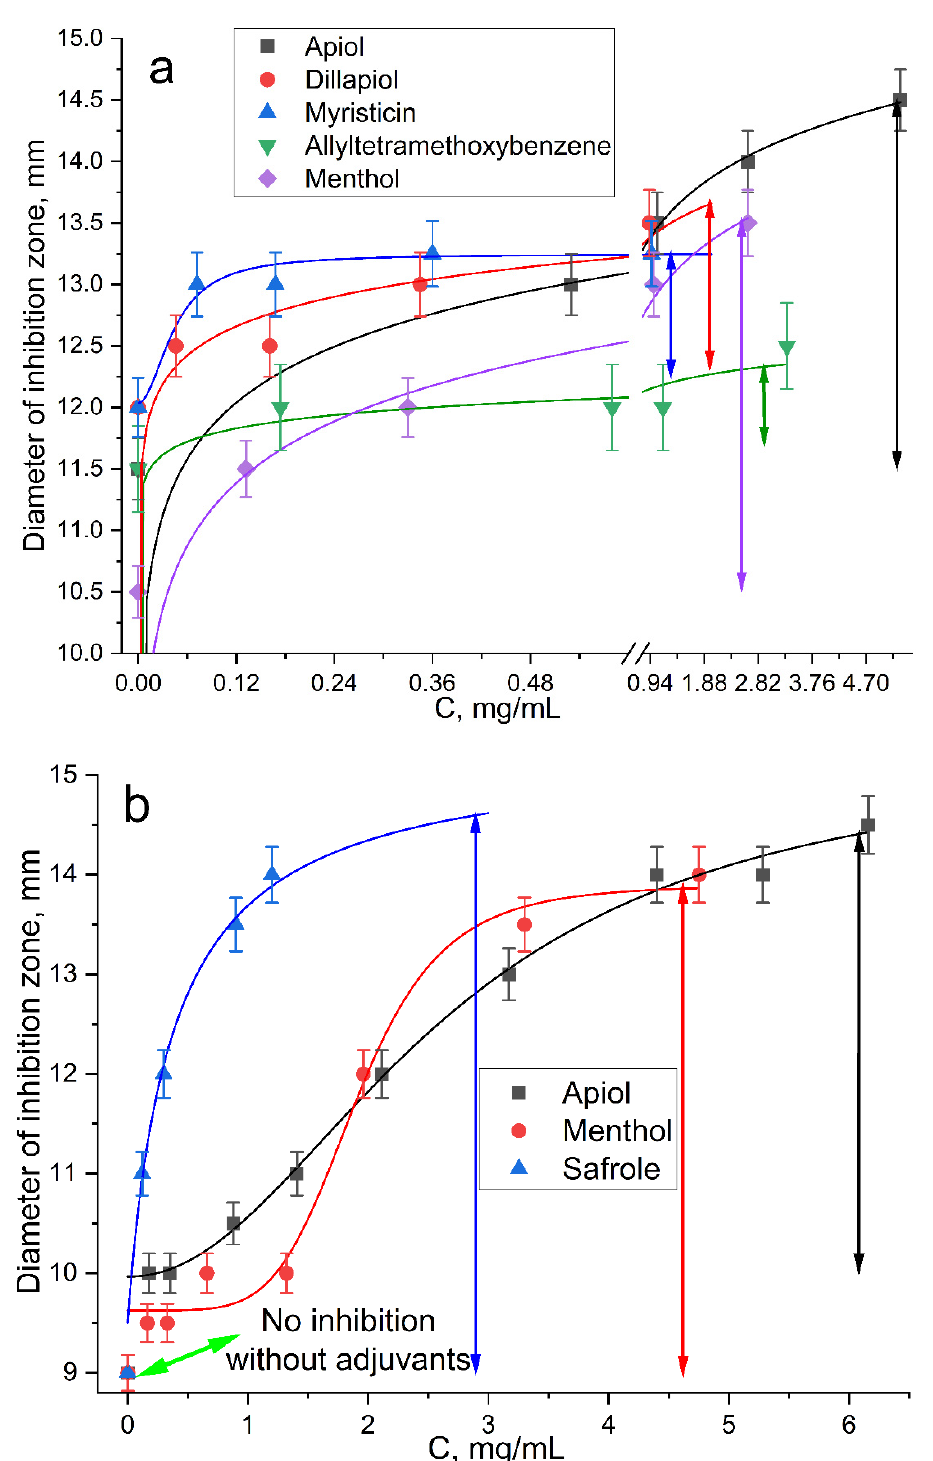
Figure 5. Diameter E. coli growth inhibition zone on Petri dishes versus concentration of adjuvant– MCD (molar ratio is 1:2) in complex formulation with ( a ) 0.10 and ( b ) 0.15 μ g/mL of Lev. The diameter of the hole was 9 mm. Inhibition is considered noticeable at D > 10 mm. pH 7.4 (0.01 M PBS), 37 °C, 24 h of incubation.